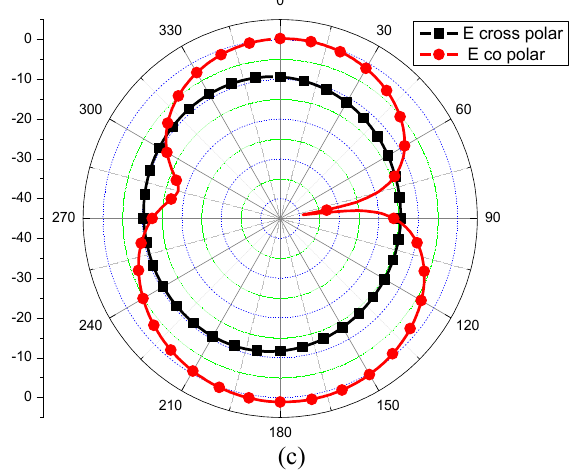
(c) Fig.10 Radiation pattern of the proposed antenna at: (a) 2.5GHz, (b) 3.62 GHz, and (c) 5.83 GHz. The radiation pattern of proposed antenna at 2.5 GHz, 3.62